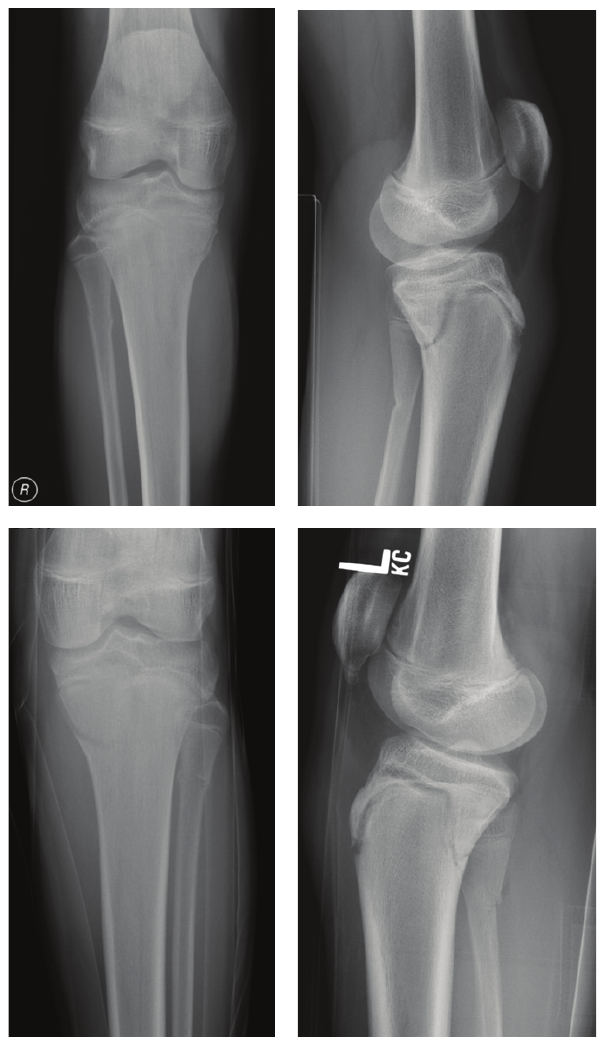
Figure 1: AP and lateral radiographs of both knees.